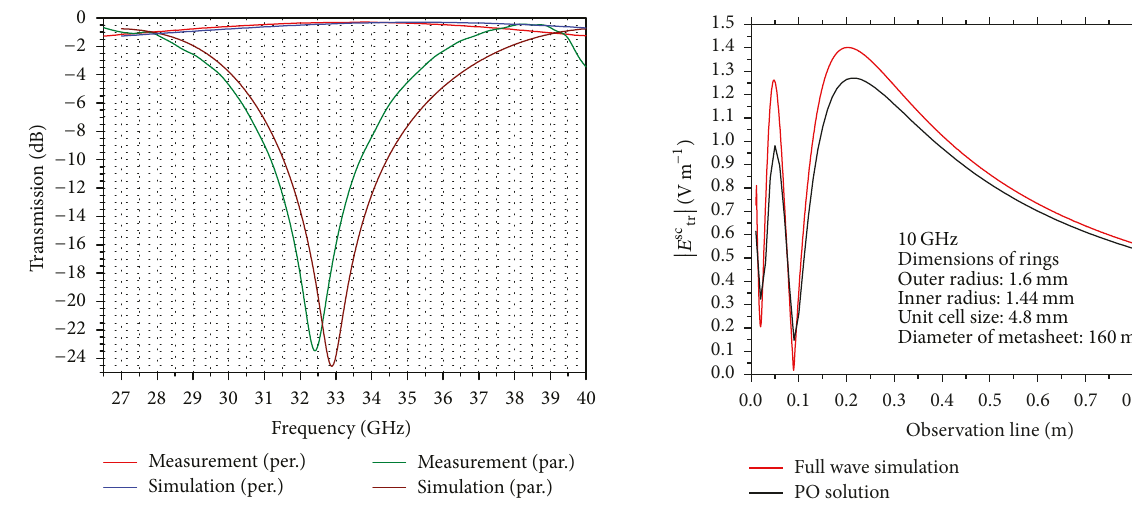
Figure 15: Scattered electric field along the observation line (along 𝑧 -axis) in the shadow region behind the metasheet